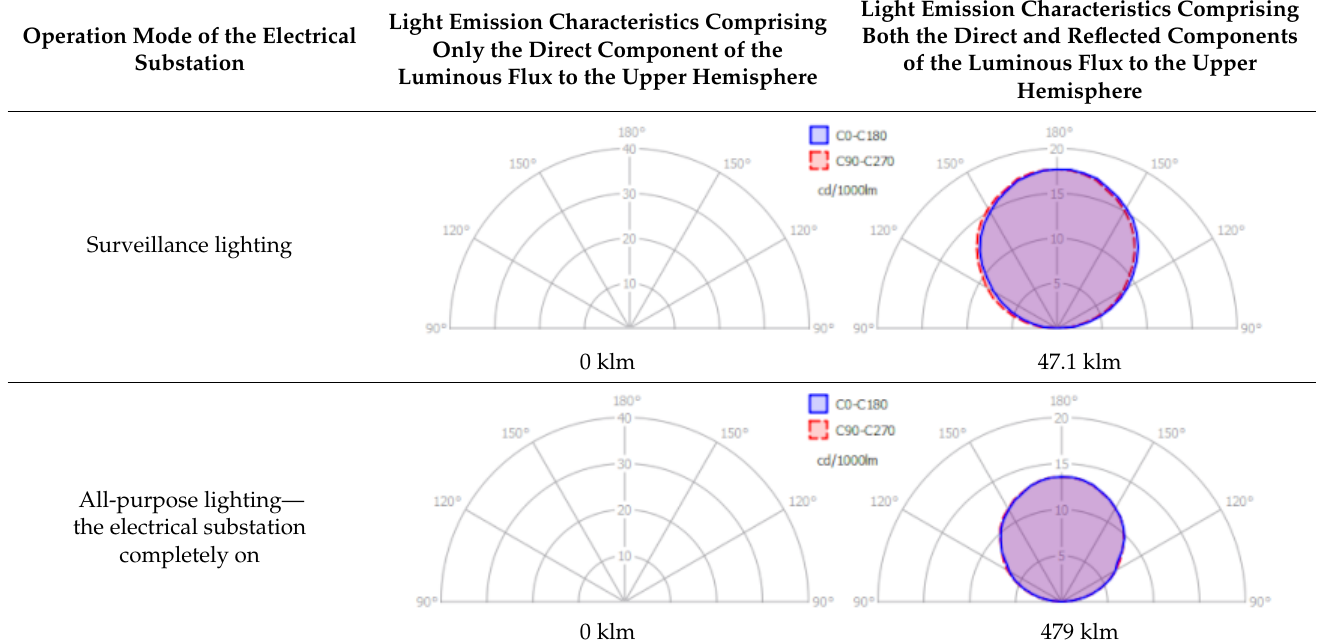
emitted by the surveillance lighting system. Table 10. Light emission characteristics of two operational modes of the electrical substation TR Slavˇetice.